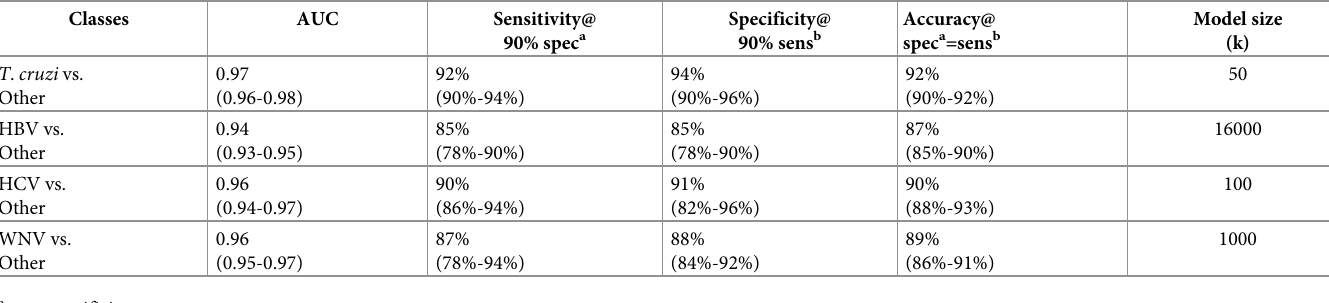
Table 4. Binary classification of each of four disease classes versus a combined class of the remaining